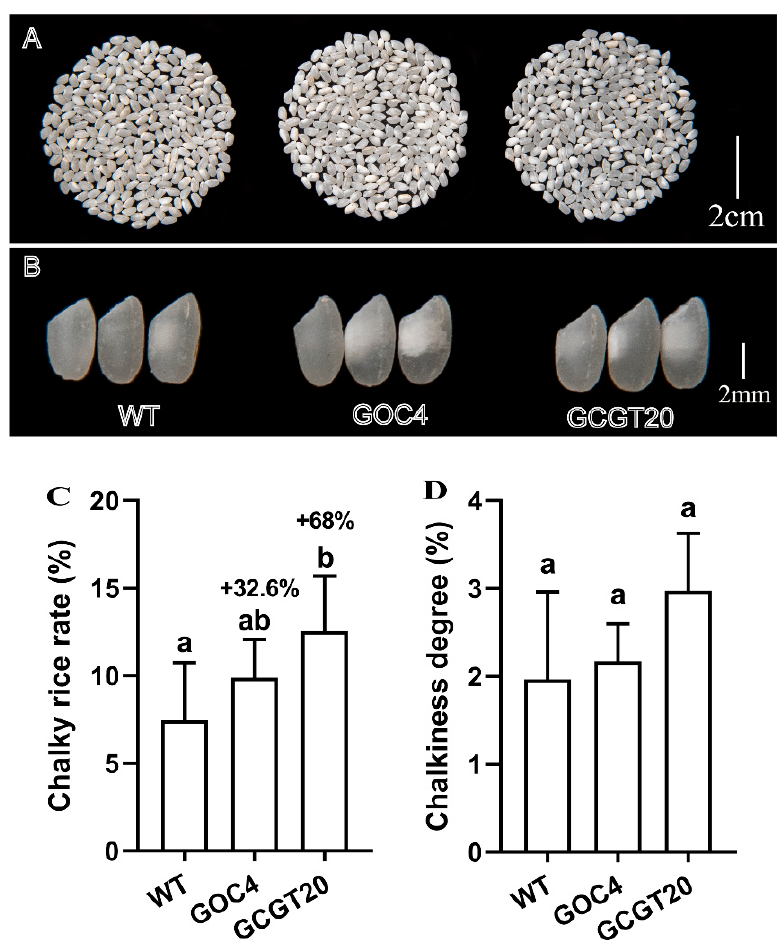
Figure 2. Appearance quality of GOC4, GCGT20, and WT rice grains. The appearance quality includes ( A , B ) the performance of the milled grain, ( C ) chalky rice rate, and ( D ) chalkiness degree. Data are presented as the mean ± SD according to one-way ANOVA followed by a Duncan’s test for means comparison. Different letters indicate significant differences ( n = 4, p < 0.05).